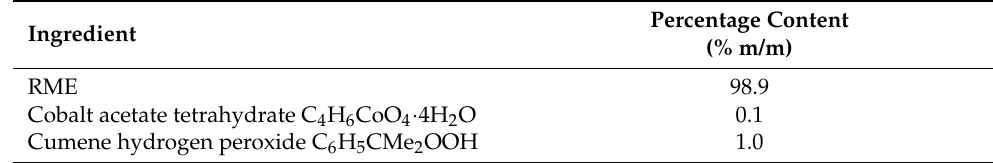
Table 2. Proportions of additives used in the RME oxidation process.